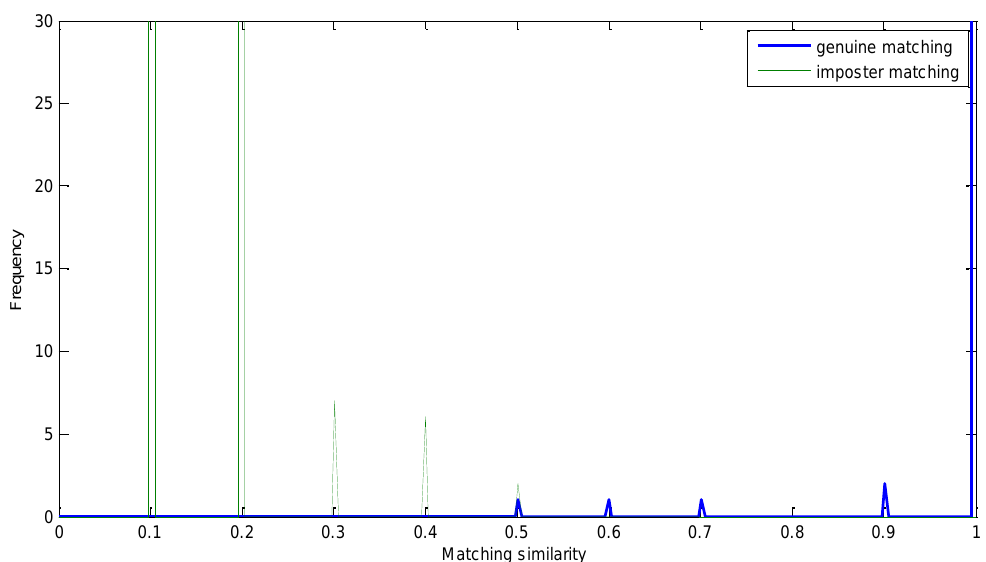
Figure 10. Similarity distribution without smooth.